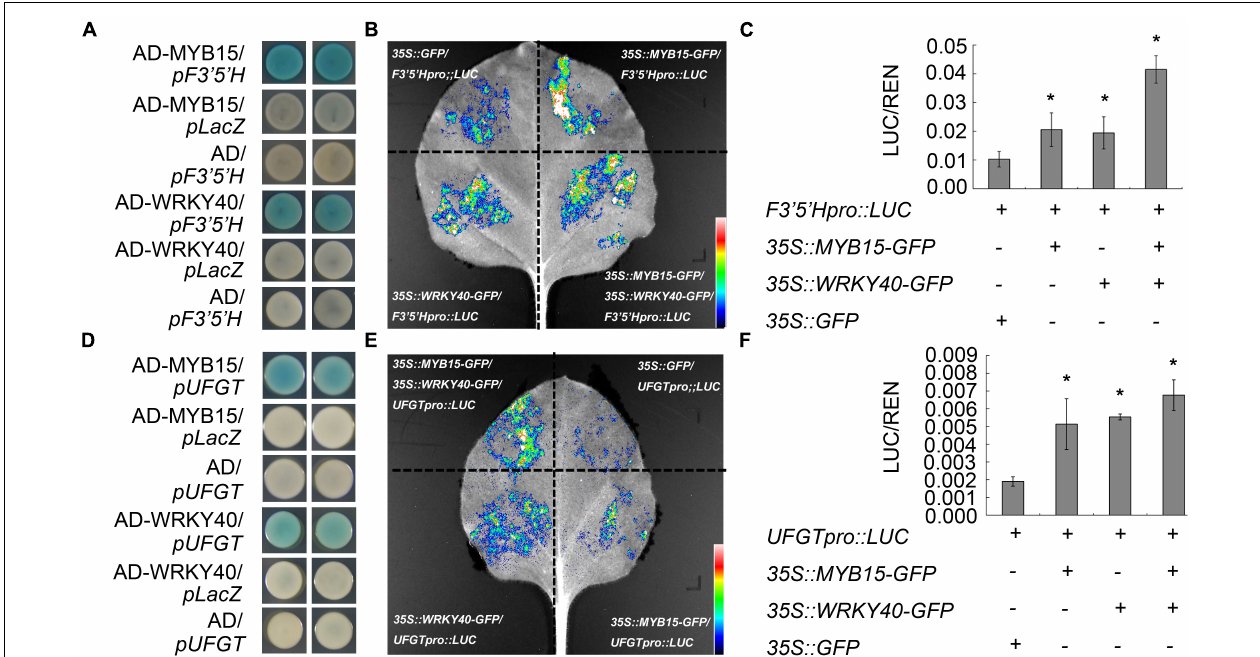
FIGURE 3 | VvMYB15 and VvWRKY40 specifically bind to the promoter region of anthocyanin biosynthesis-related genes. (A) Yeast-one-hybrid showing VvMYB15 and VvWRKY40 bind the promoter of VvF3 (cid:48) 5 (cid:48) H , respectively. (B) Yeast one hybrid showing VvMYB15 and VvWRKY40 bind the promoter of VvUFGT , respectively. Blue color represents the expression of LacZ reporter gene. Analysis of the relative fluorescence intensity shown in panels (C,D) , the fluorescence intensity of control was used as reference. (E) VvMYB15 and VvWRKY40 activated the expression of VvF3 (cid:48) 5 (cid:48) H . Nicotiana benthamiana leaves were co-infiltrated with Agrobacterium strains carrying the indicated constructs. Control ( 35S::GFP / F3 (cid:48) 5 (cid:48) Hpro::LUC ), co-expression of 35S::VvMYB15-GFP/F3 (cid:48) 5 (cid:48) Hpro::LUC , co-expression of 35S::VvWRKY40-GFP / F3 (cid:48) 5 (cid:48) Hpro::LUC ; co-expression of 35S::VvMYB15-GFP/35S::VvWRKY40-GFP / F3 (cid:48) 5 (cid:48) Hpro::LUC . (F) VvMYB15 and VvWRKY40 activated the expression of VvUFGT . Nicotiana benthamiana leaves were co-infiltrated with Agrobacterium strains carrying the indicated constructs. Control ( 35S::GFP / UFGTpro::LUC ), co-expression of 35S::VvMYB15-GFP/UFGTpro::LUC ; co-expression of 35S::VvWRKY40-GFP / UFGTpro::LUC ; co-expression of 35S::VvMYB15-GFP/35S::VvWRKY40-GFP / UFGTpro::LUC . Expression values were determined by calculating the ratio of LUC activity to REN activity (LUC/REN). The error bars show average ± SE of six biological replicates. “+” indicates the presence of corresponding protein, “–” indicates the absence of